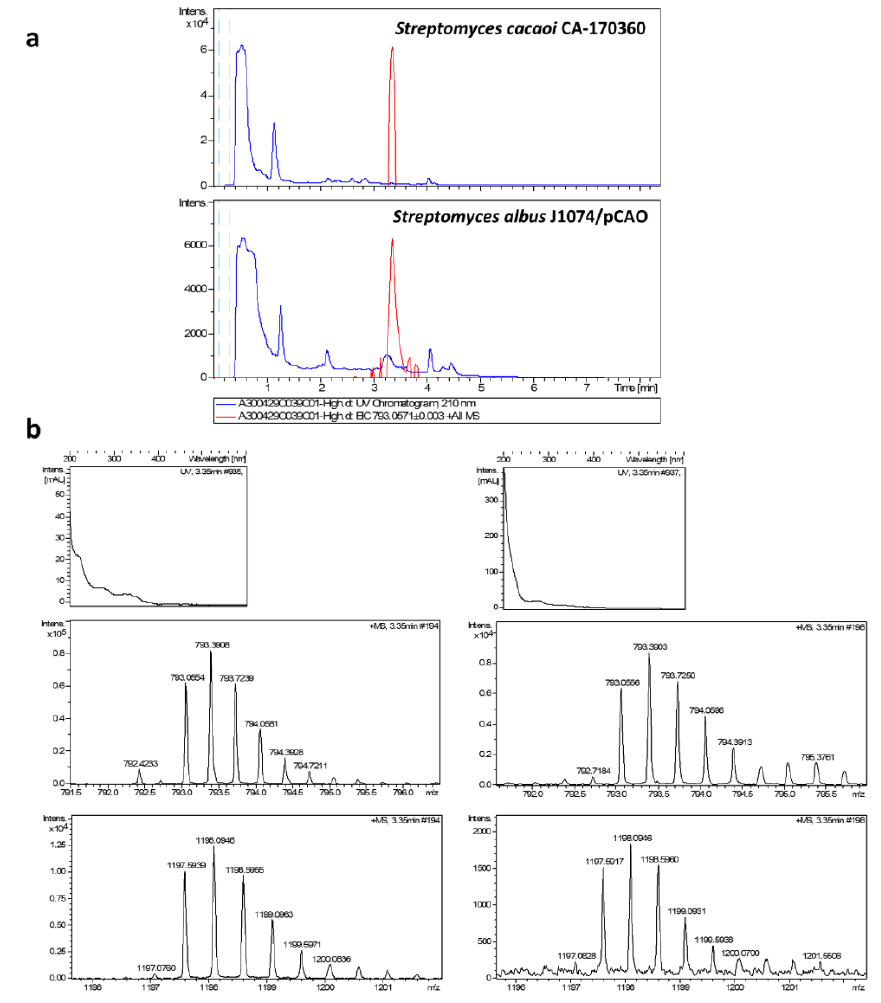
Figure 3. ( a ) Chromatograms of UV absorbance at 210 nm (blue trace) and extracted ion m / z = 793.0571 ± 0.003, C 107 H 162 N 24 O 32 S 2 + NH 4+ + 2H + of cacaoidin (MDN-0207) from original producing strain Streptomyces cacaoi CA-170360 and the heterologous producing strain Streptomyces albus J1074 /pCAO. ( b ) Experimental UV and positive mass spectra from C 107 H 162 N 24 O 32 S 2 + NH 4+ + 2H + (calculated value: 793.0571) ( top ) and C 107 H 162 N 24 O 32 S 2 + 2NH 4+ (calculated value: 1197.5952) ( bottom ) adducts from heterologous producing strain ( right ) and from original producing strain CA-170360 ( left ).